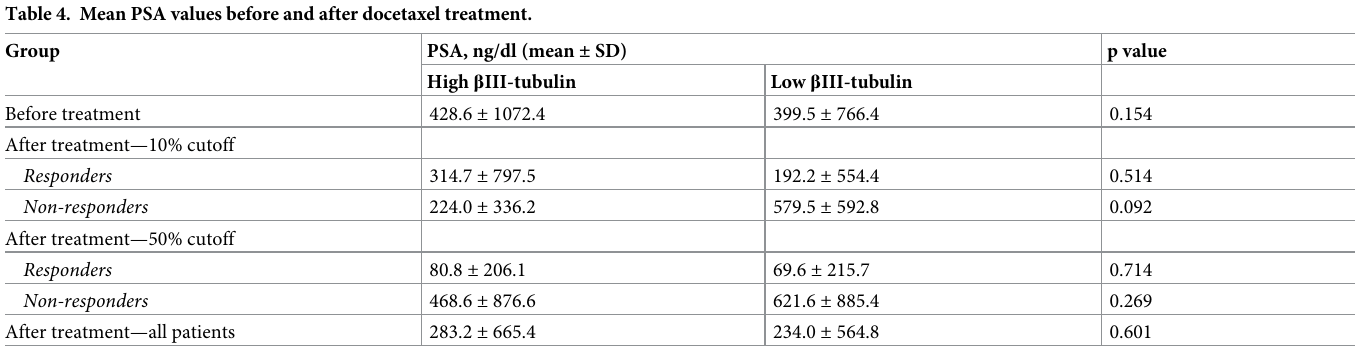
Table 4. Mean PSA values before and after docetaxel treatment.